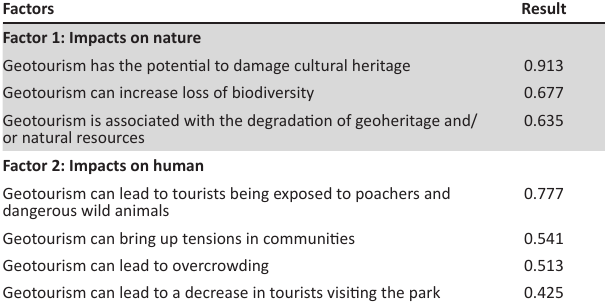
TABLE 7: Factor analysis for potential challenges of